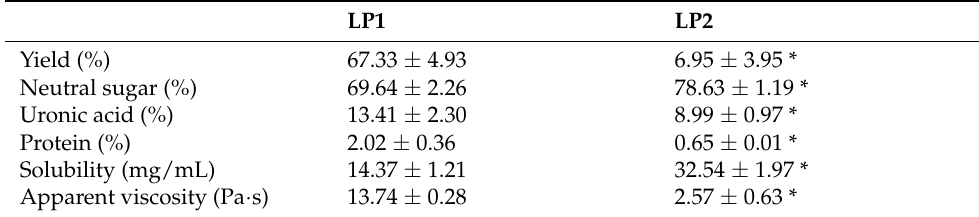
Table 1. Basic characterization of LP1 and LP2.